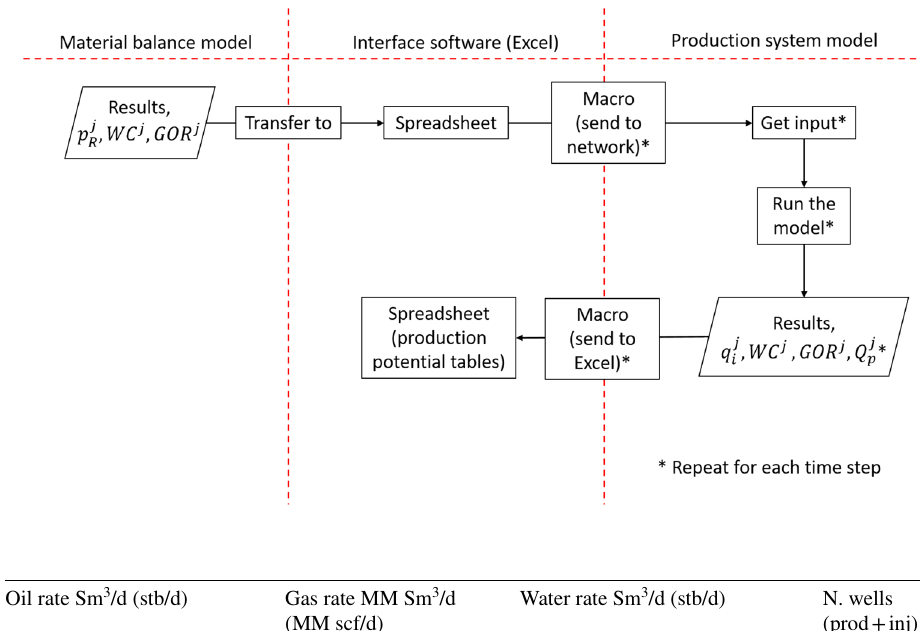
Fig. 3 Coupling process used